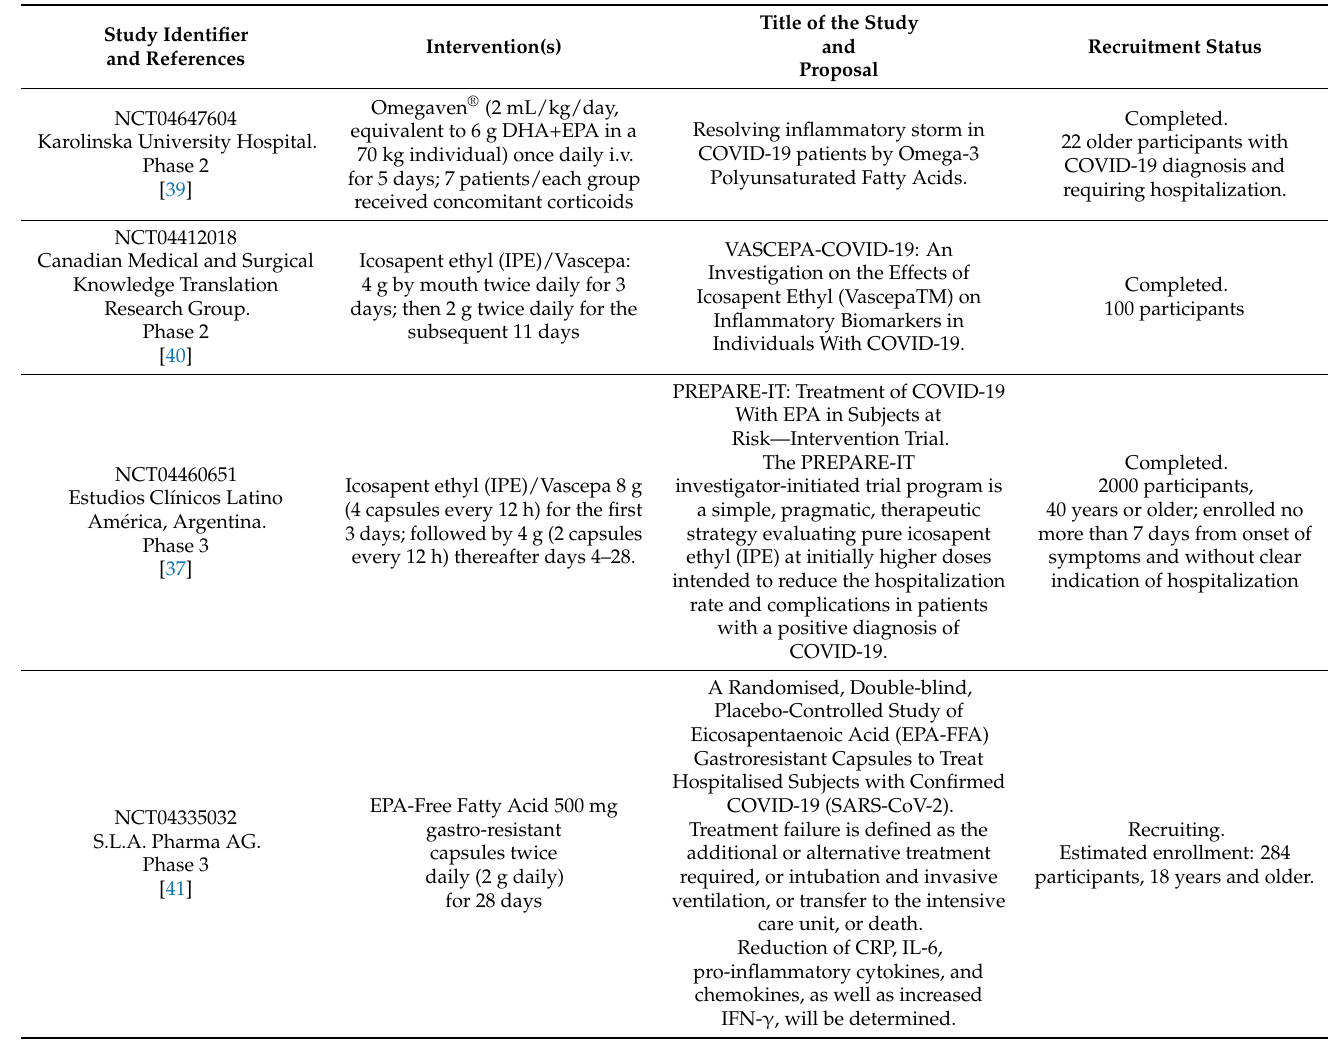
Table 2. Clinical trials approved for the use of n-3 PUFAs for COVID-19